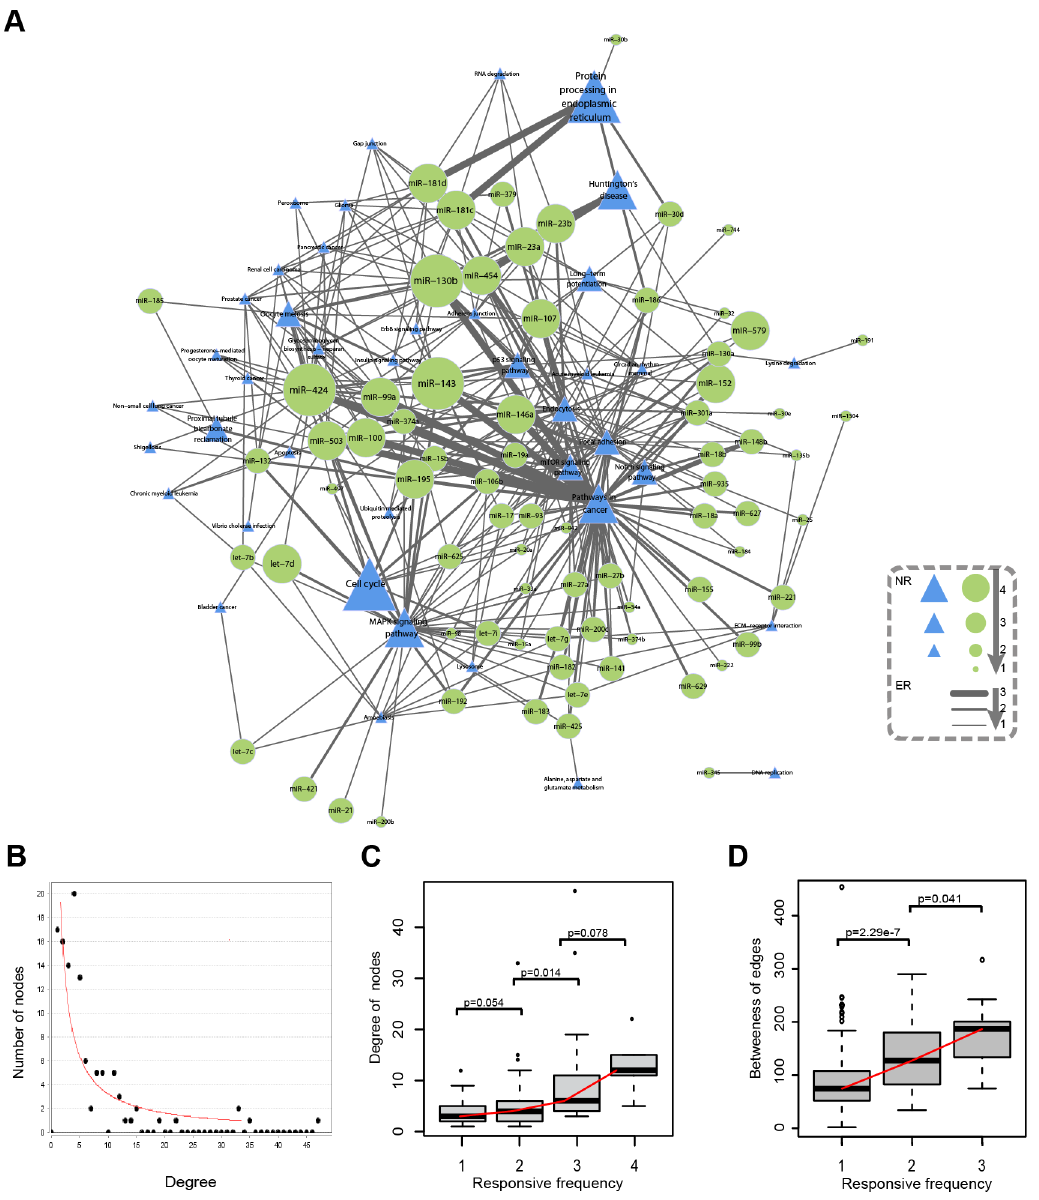
Figure 5. The comprehensive MPRN (cMPRN) and correlation between response frequency of miRNA-pathway regulations and their network centrality. (A) cMPRN was generated by integrating the six MPRNs corresponding to each experimental manipulation. Green circles and blue triangles represent functional miRNAs and target pathways, respectively. Node size and edge thickness are correlated with response frequency. (B) The degree distribution of cMPRN follows the power law. (C) The degree of nodes (including pathways and miRNAs) was positively correlated with their response frequency to different manipulations. (D) The betweenness of edges (miRNA-pathway regulation) was positively correlated with their response frequency.